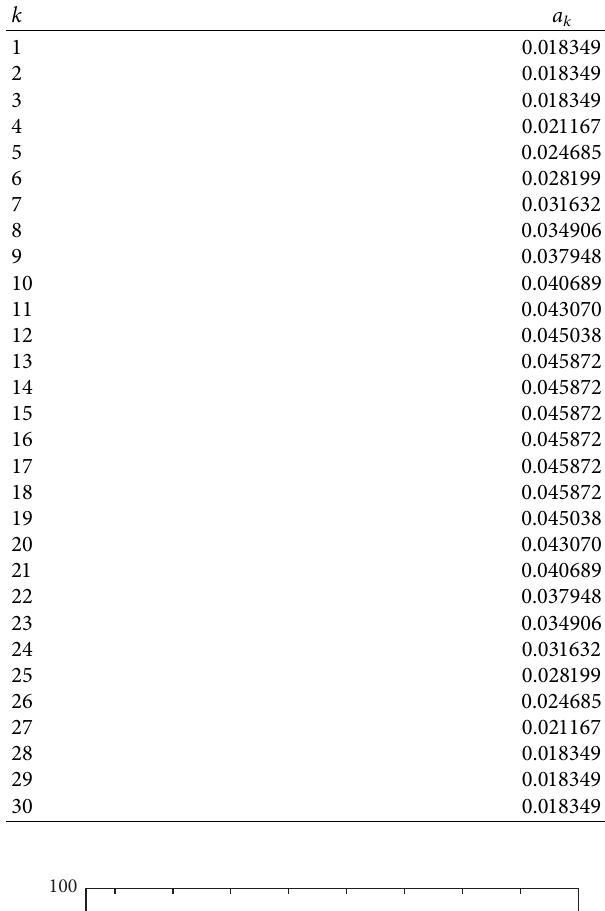
Table 9: Optimum coefcients of proposed array from Table 7, obtained for D � 2.5.